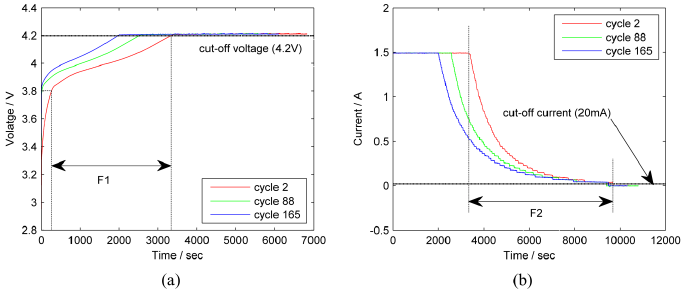
Figure 1. The first and second charge-related features extracted from the charge step. feature extracted from the constant-current charge step; ( b ) The second feature extracted from the constant-voltage charge